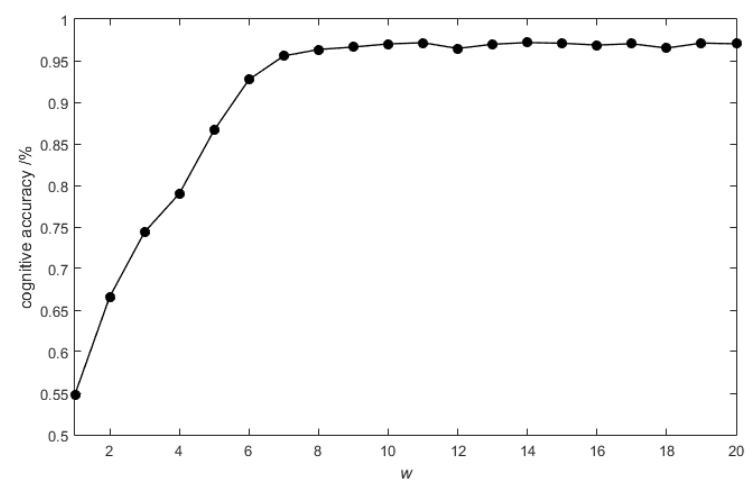
Figure 7. Cognitive accuracy vs. feedback cognition number w .